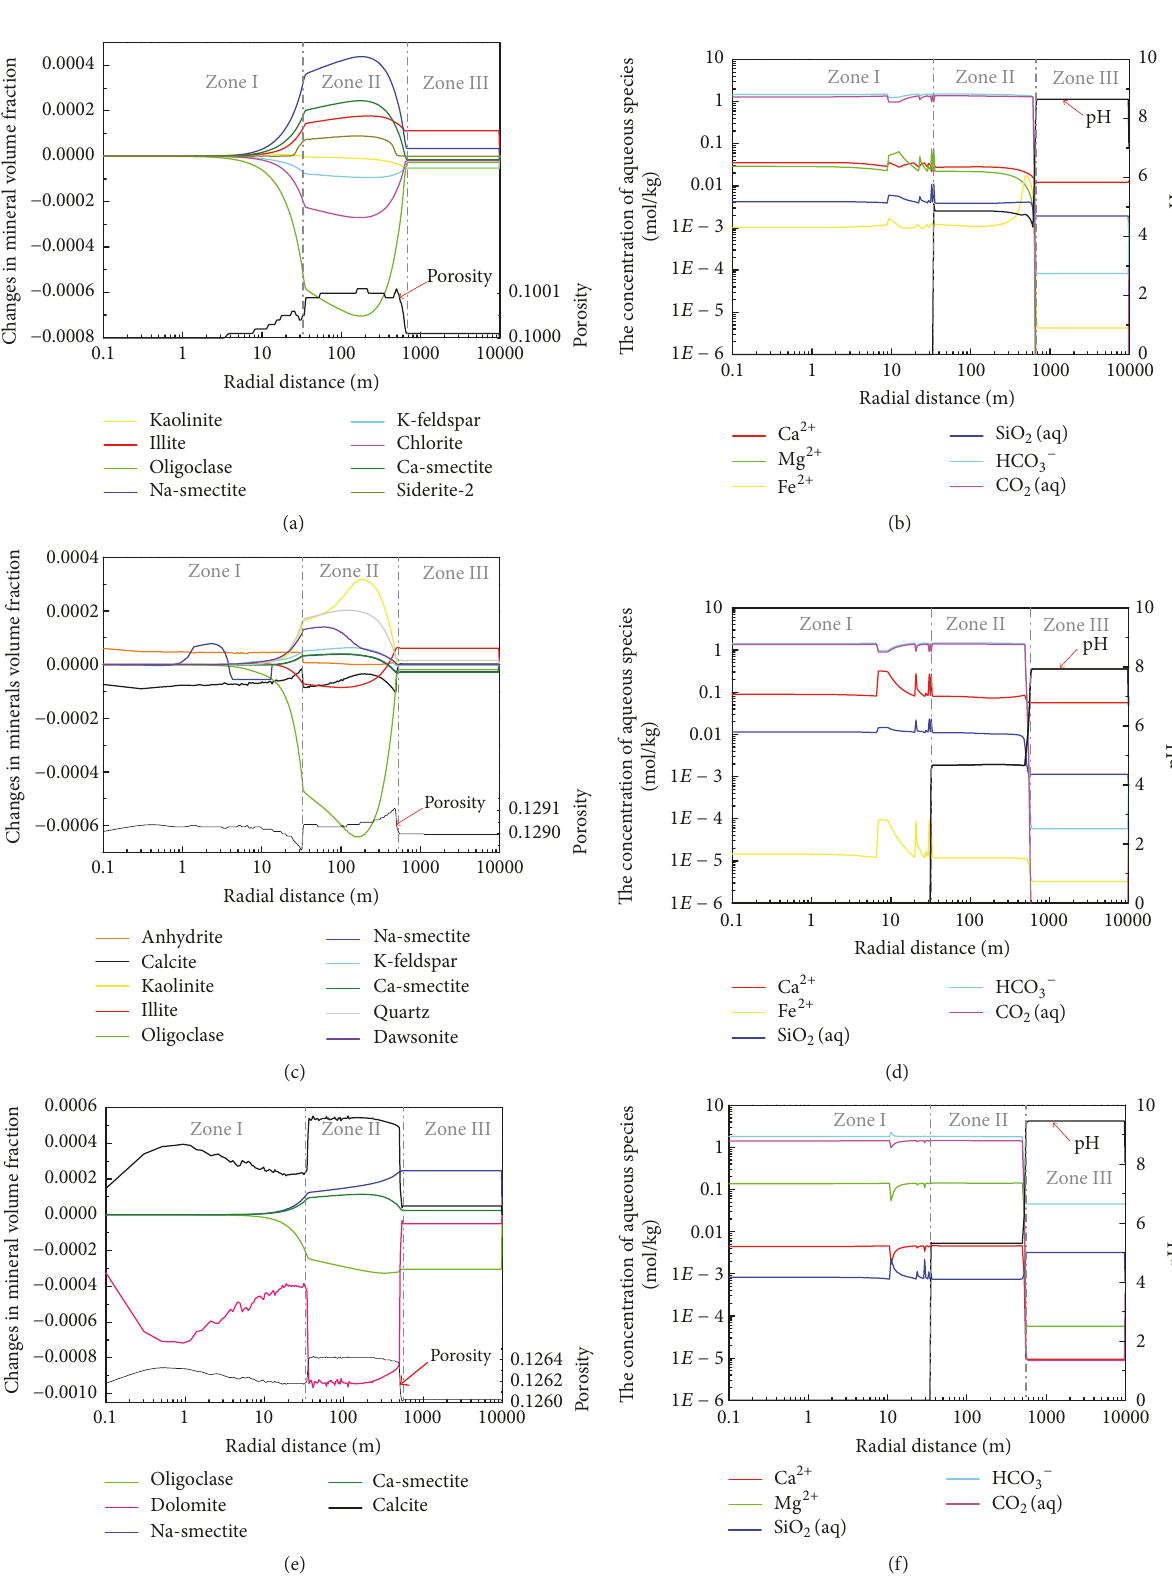
Figure 2: The horizontal distribution of changes in main mineral volume fraction, porosity, and concentrations of major aqueous species and pH for Liujiagou formation (a, b), Shiqianfeng formation (c, d), and Shihezi formation (e, f) along the horizontal direction at the depth of − 75 m after 30 years of CO 2